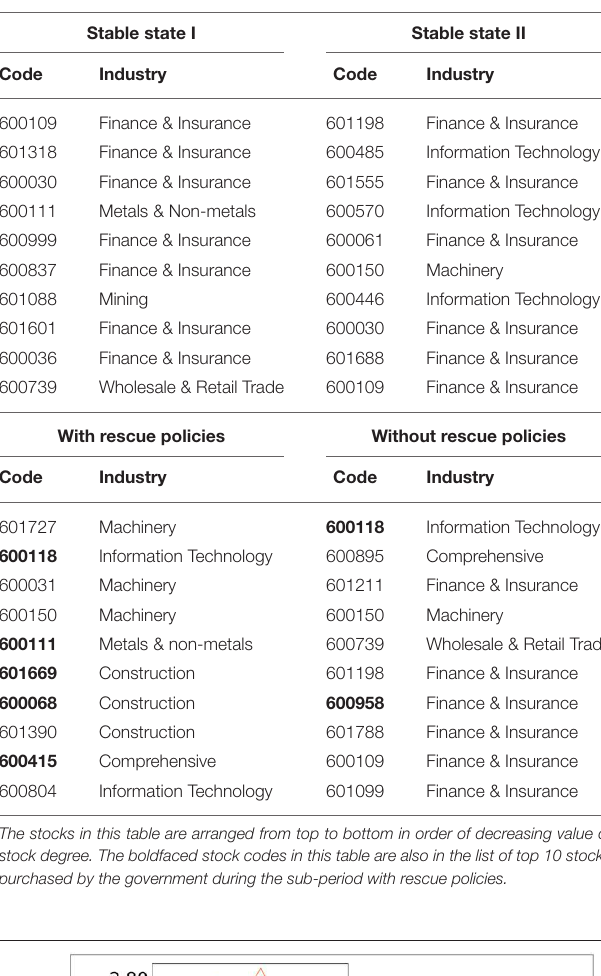
TABLE 6 | Top 10 stocks with the highest mean value of degrees in the stock network for the two stable-state sub-periods and the sub-periods with and without rescue policies in the Shanghai stock market.